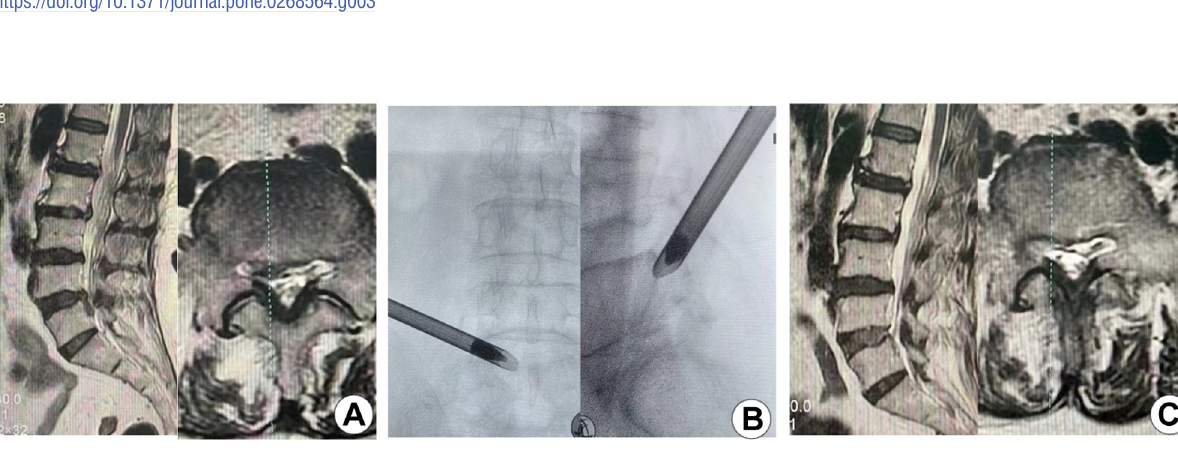
PLOS ONE | https://doi.org/10.1371/journal.pone.0268564 May 24,